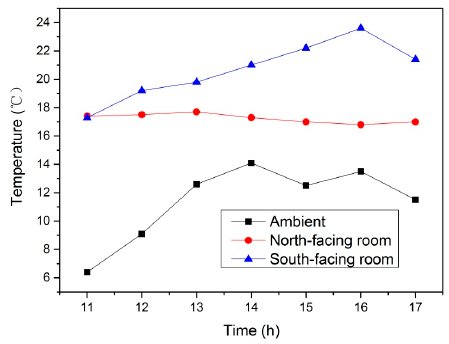
Figure 11. Variations of the room temperatures and the ambient temperature.